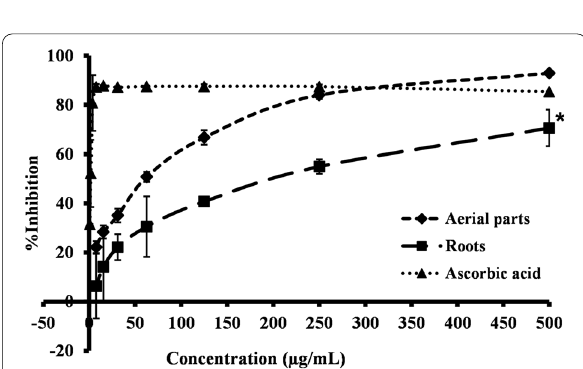
Fig. 2 % Viability of HSF 1189 with different concentrations of A. indica extracts. Values are expressed as mean analysis was carried out using one-way ANOVA followed by t test. *Statistically significant between extract concentrations vs. the untreated control at * p <